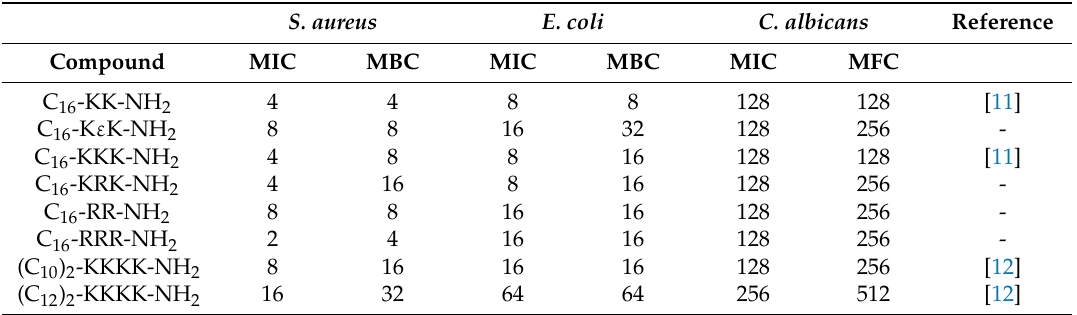
Table 1. Minimum inhibitory concentrations (MIC) (mg/L) and minimum bactericidal/fungicidal concentrations (MBC/MFC) (mg/L) of the